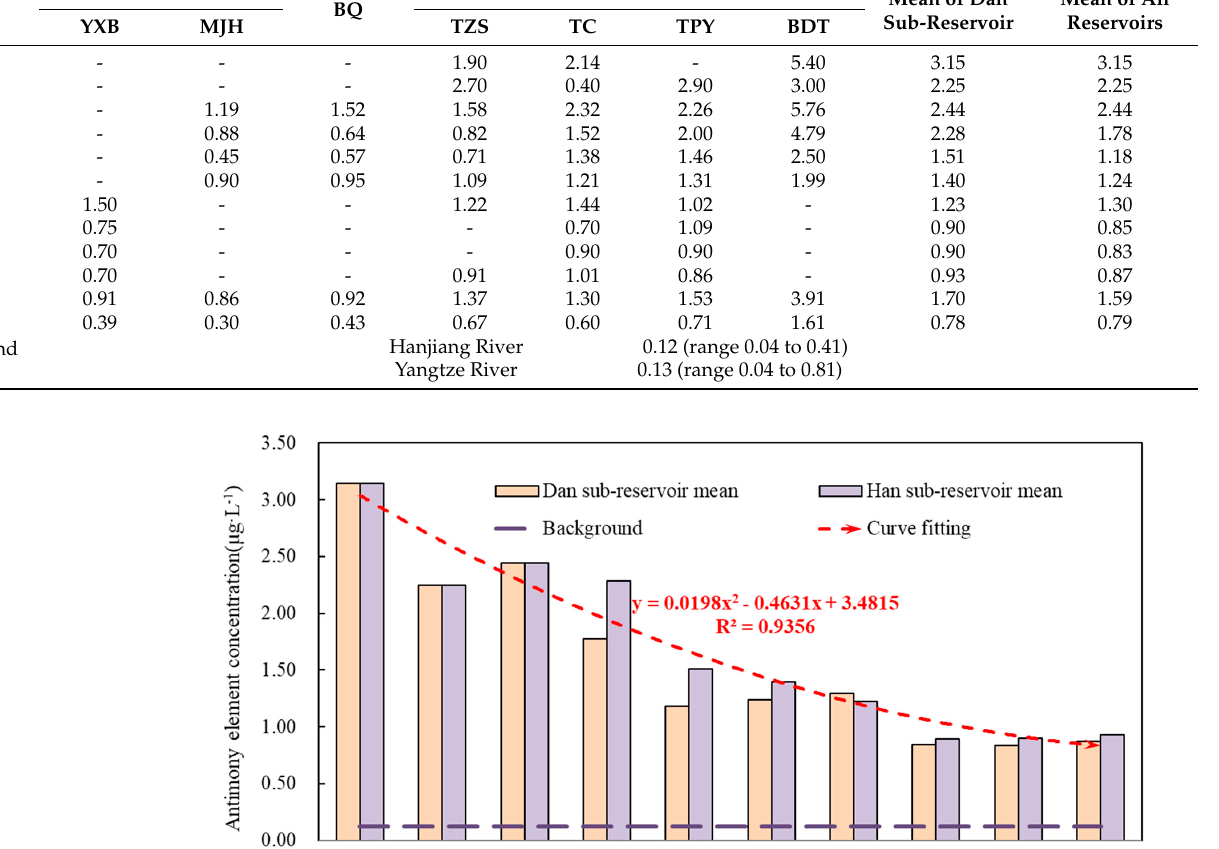
Table 1. Statistics of antimony monitoring results in Danjiangkou Reservoir water bodies ( µ g L − 1 ). Projects